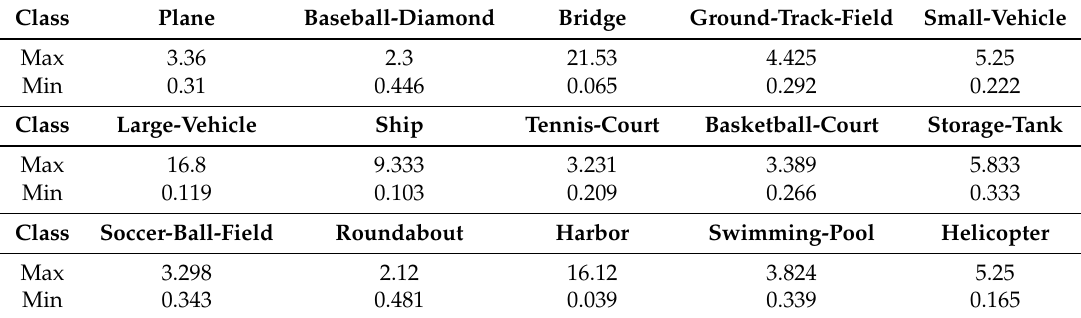
Table 1. The maximum and minimum aspect ratios of different classes of samples in the training